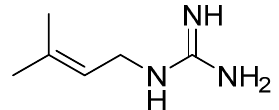
Figure 5. Chemical structure of the natural blood glucose lowering agent galegine.